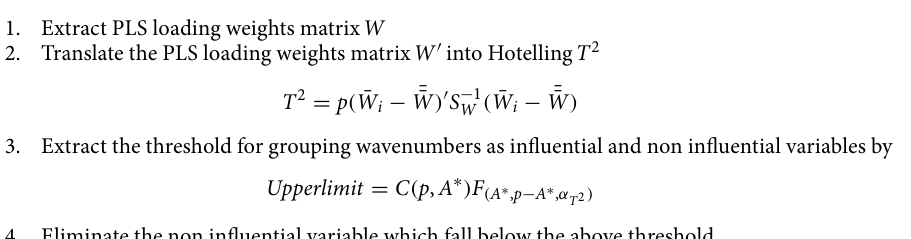
2 -PLS is presented in upper and lower panel